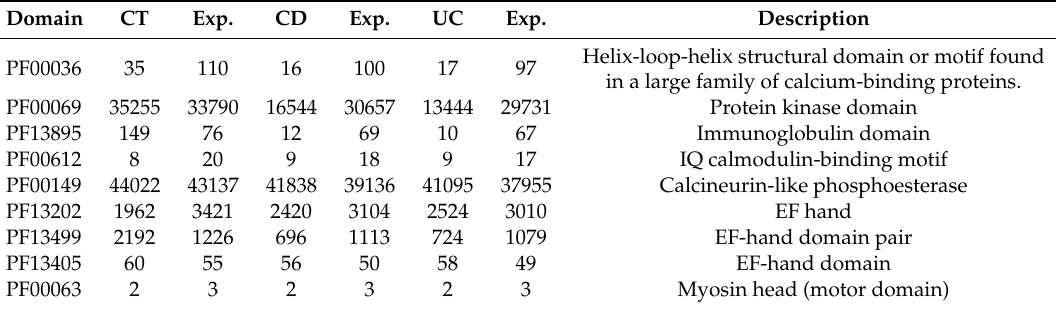
Table 3. The occurrence of S100B interacting functional domains over samples categories. The expected value by chance is reported. In the top those statistically significant (chi-squared Test, p < 0.01). In the bottom part, the domains not significantly supported ( p > 0.5). Exp.: Expected Value. Domain CT Exp. Exp. Exp. Description Helix-loop-helix structural domain or motif found 97 in a large family of calcium-binding